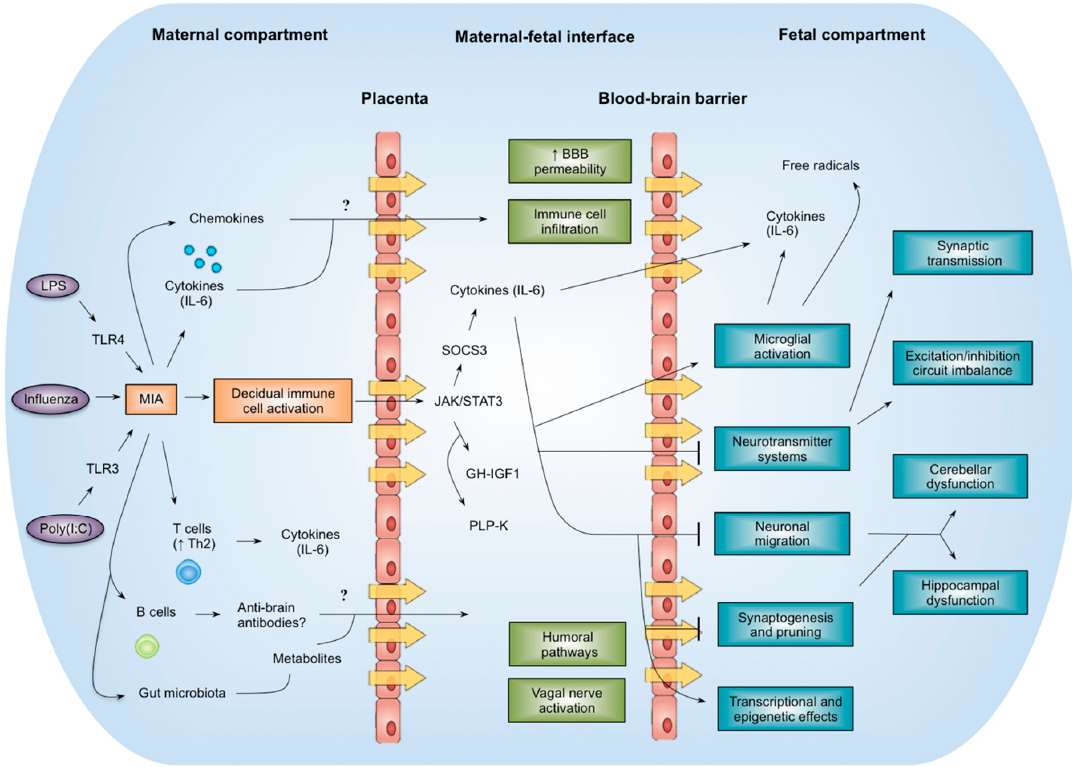
Figure 3. Sites of action and mechanisms of MIA.